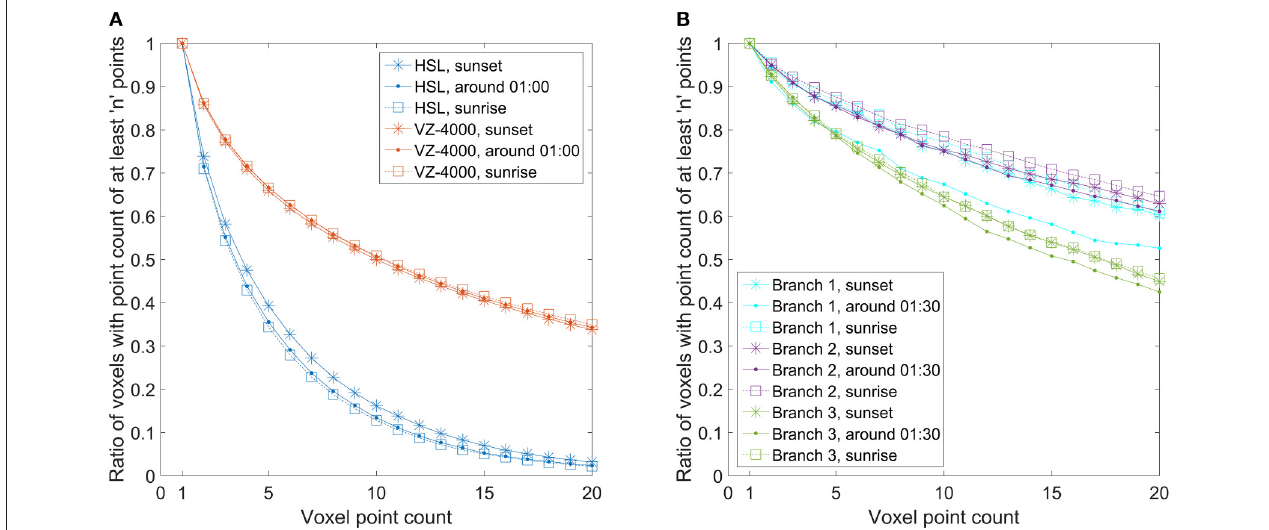
FIGURE 6 | Normalized cumulative number of voxels populated with at least N points. Voxel size was set to 5 × 5 × 5cm 3 in each Finnish and Austrian birch point cloud. (A) Normalized cumulative number of voxels with at least N points calculated for the Finnish birch crown point clouds and for the full Austrian birch point clouds. (B) Normalized cumulative number of voxels with at least N points calculated for the selected branch point clouds differentiated from the full Austrian point